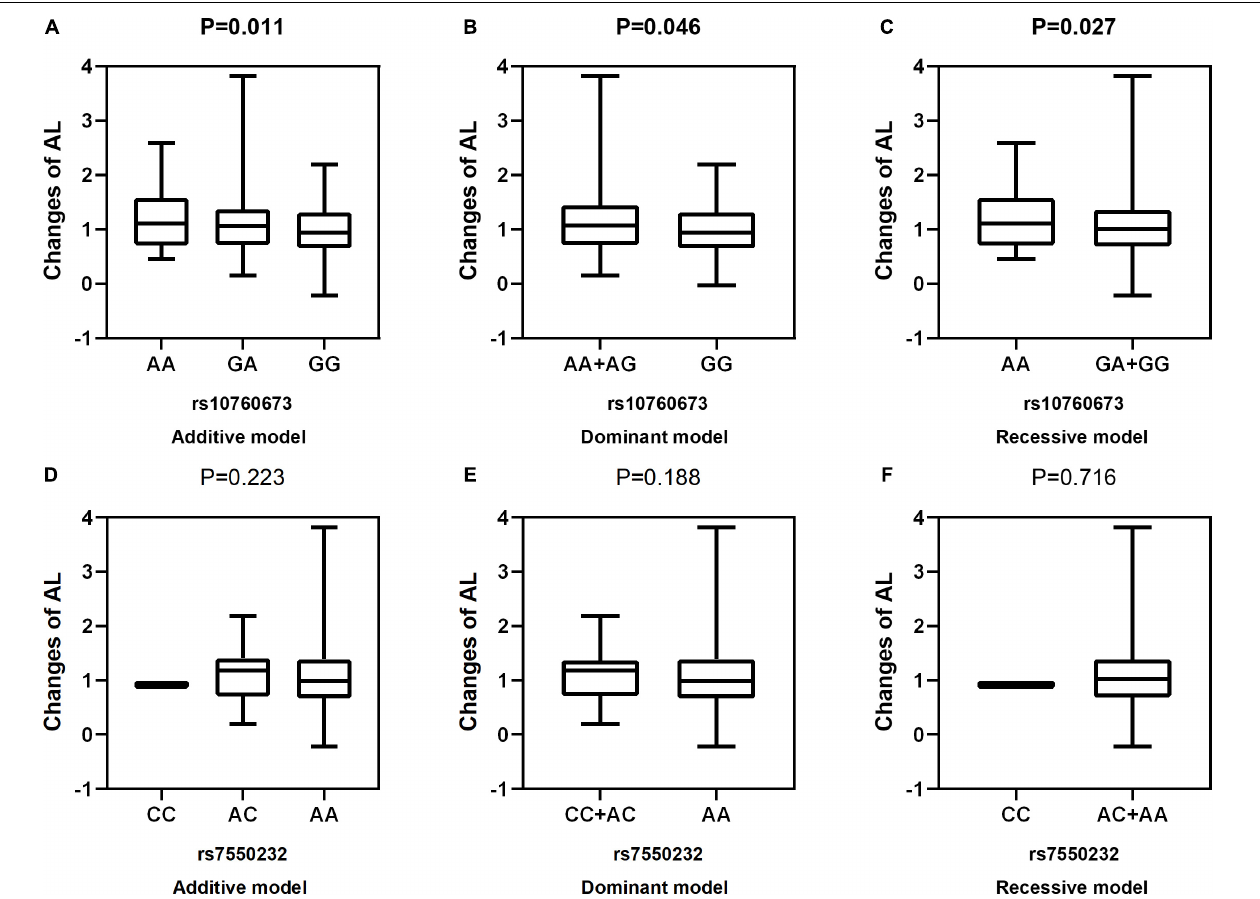
FIGURE 3 | Correlations between the two SNPs and the changes in AL. rs10760673 [ (A) additive model, p = 0.011; (B) dominant model, p = 0.046; (C) recessive model, p = 0.027]; rs7550232 [ (D) additive model, p = 0.223; (E) dominant model, p = 0.188; (F) recessive model, p =